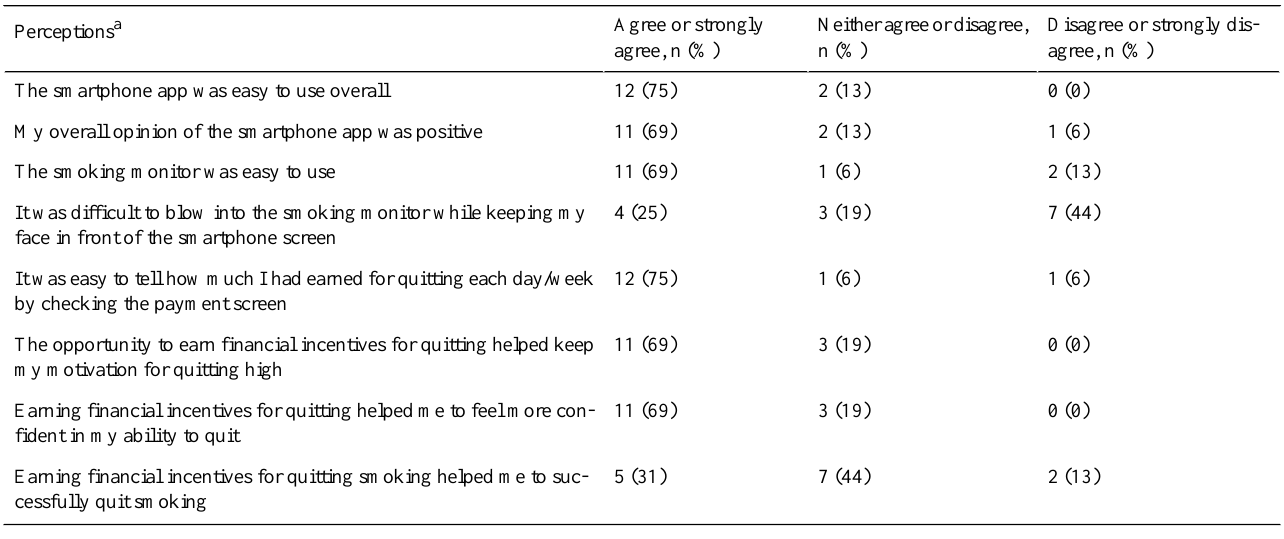
Table 3. Participants’perceptions of the automated mobile contingency management intervention 4 weeks after a scheduled quit attempt (N=16).